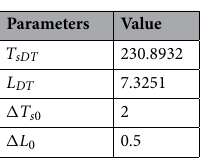
Table 8. Parameters of the target